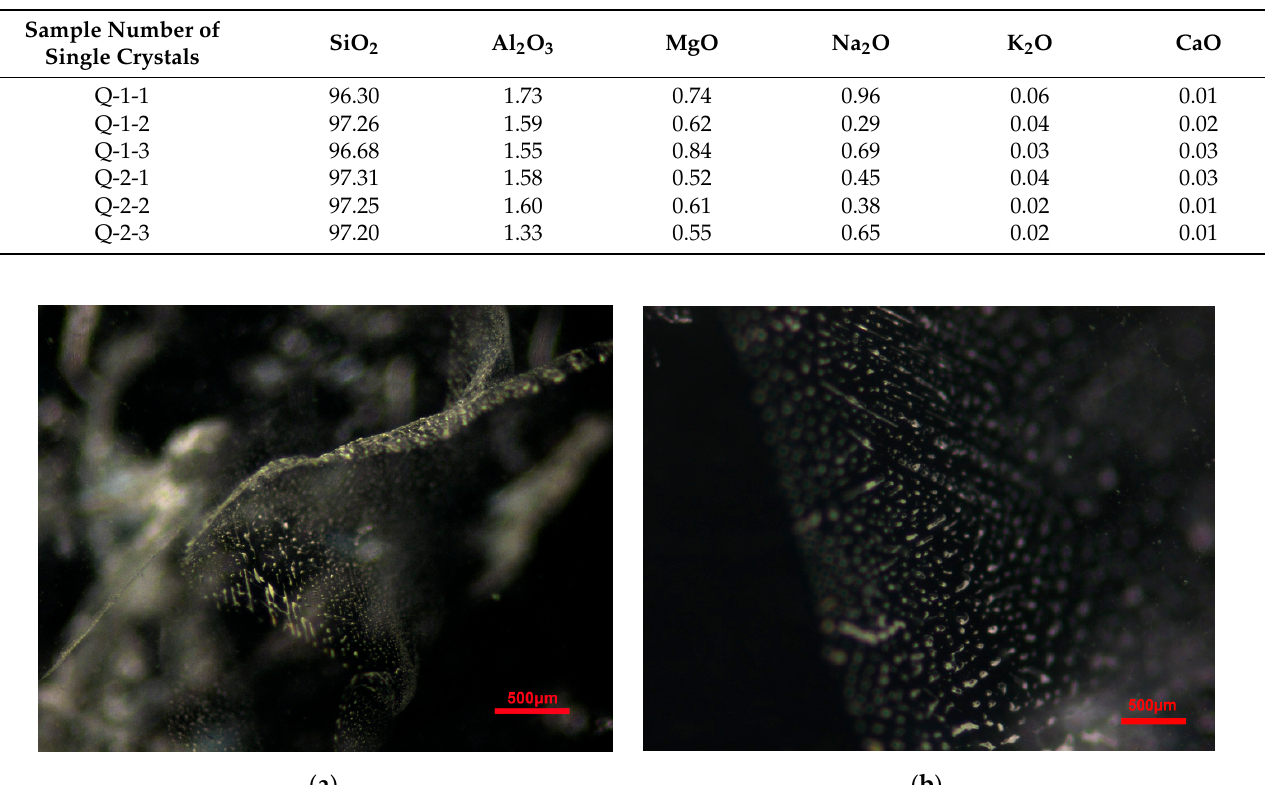
( b ) Figure 3. 3D images of microstructure characteristics of the regrown quartz crystal. ( a ) Side view image, ( b ) top view image. (inside the dotted line—the natural section; outside the dotted line—the synthetic section).